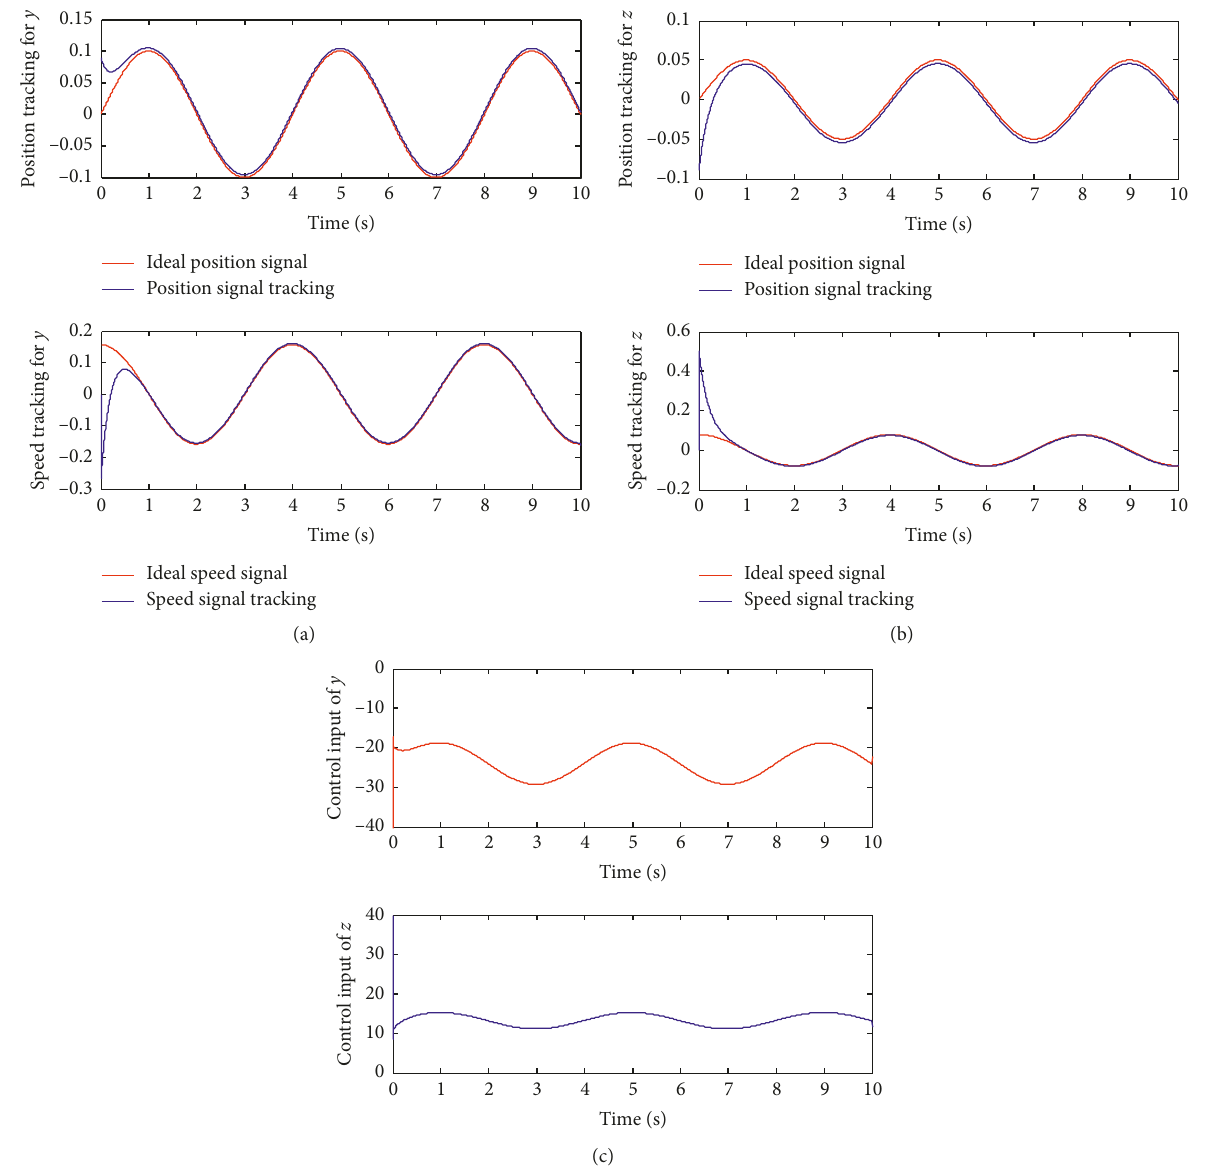
Figure 3: The controlled displacements (position signal tracking curves) and velocities (speed signal tracking curves) of flap(z)/lead-lag(y) motions, and the signals of control inputs, controlled by using the SM-PI.